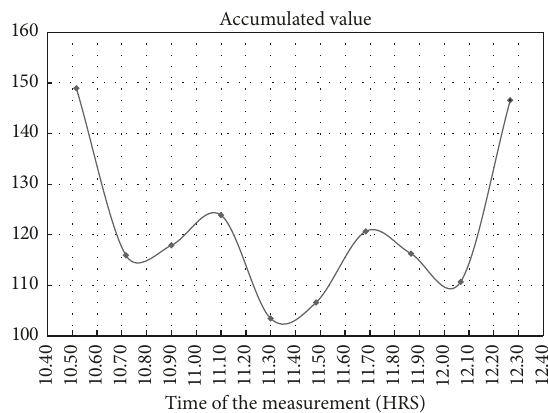
Figure 13: Variations on the accumulated value 𝑆 as a function of